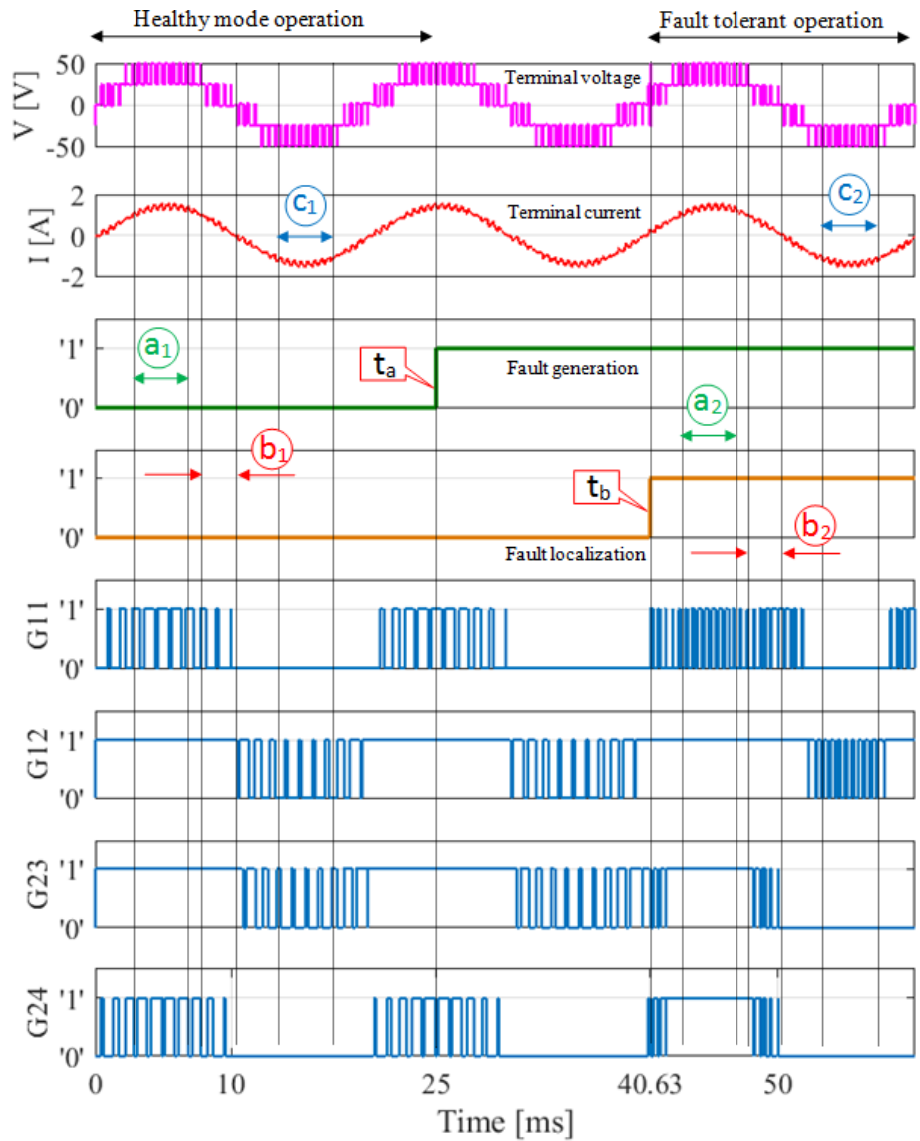
Figure 10. Simulation results for fault-tolerant operation of the inverter in the case of a short-circuit fault event in S23.